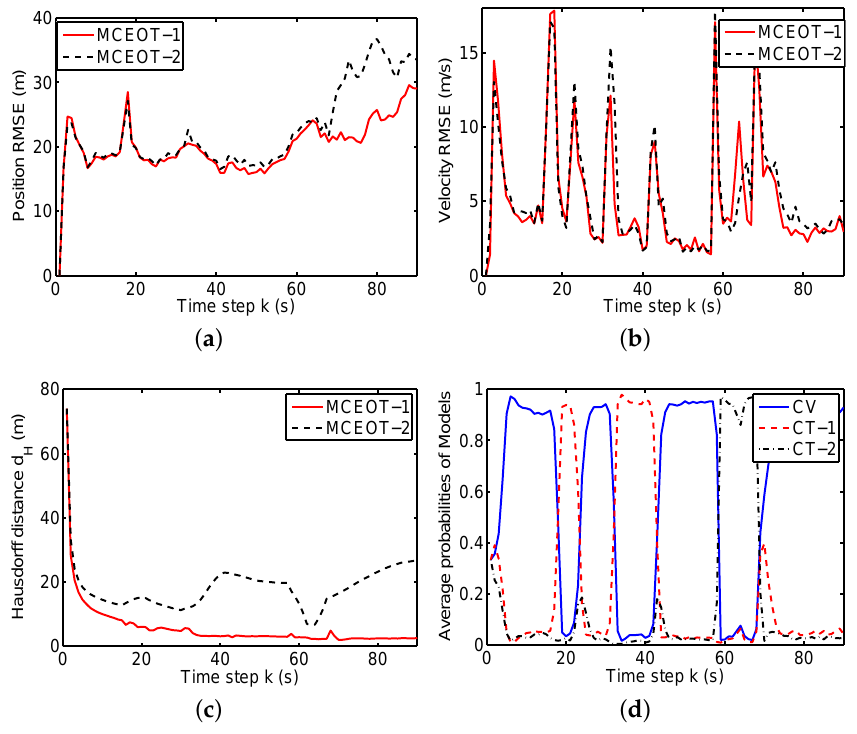
Figure 6. Performance comparison for scenario B. ( a ) position RMSE; ( b ) velocity RMSE; ( c ) Hausdorff distance; ( d ) average probability of